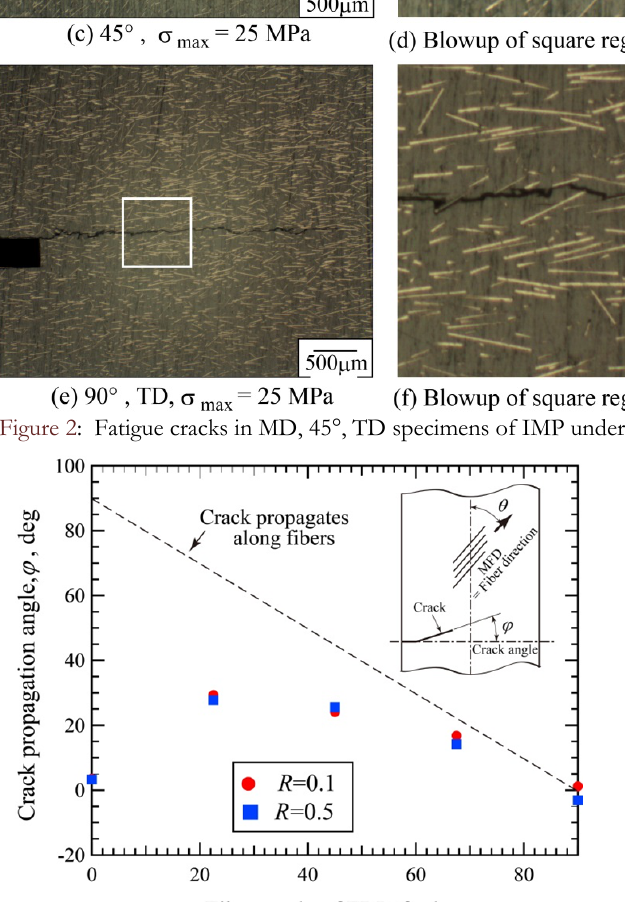
Figure 3: Relation between crack propagation angle and fiber angle.